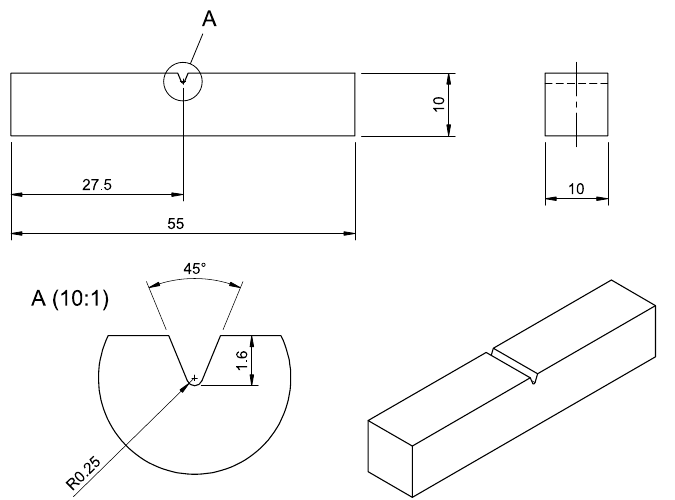
Figure 4. Charpy specimen design with the V notch according to the standard [22], units: mm.